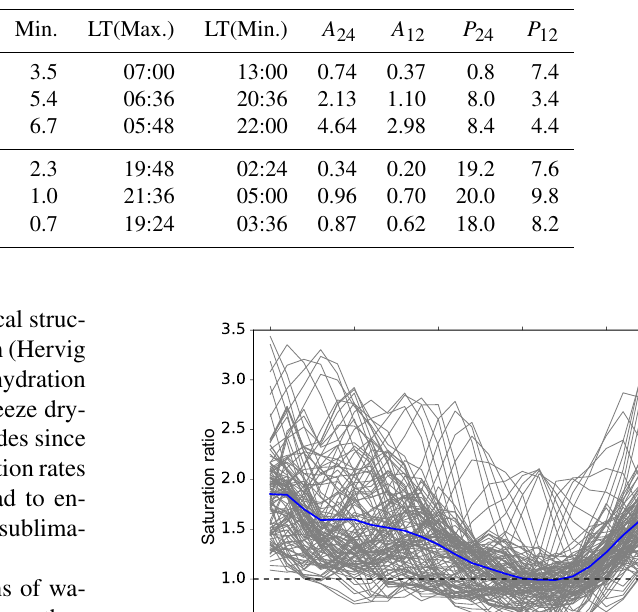
Table 2. Local time variation derived from daily data of H 2 O (ppmv) for two heights (km) at different latitudes for July 2009; see text for more details. Mean: mean H 2 O over a daily cycle; Max.: maximum H 2 O over a daily cycle; Min.: minimum H 2 O over a daily cycle; LT(Max.): local time (LT) in hours of Max.; LT(Min.): local time (LT) in hours of Min.; A 24 : diurnal amplitude from a harmonic fit including 24 and 12h components; A 12 : same but for the semidiurnal amplitude; P 24 : diurnal phase of A 24 in LT hours of maximum; P 12 : same but for semidiurnal phase.